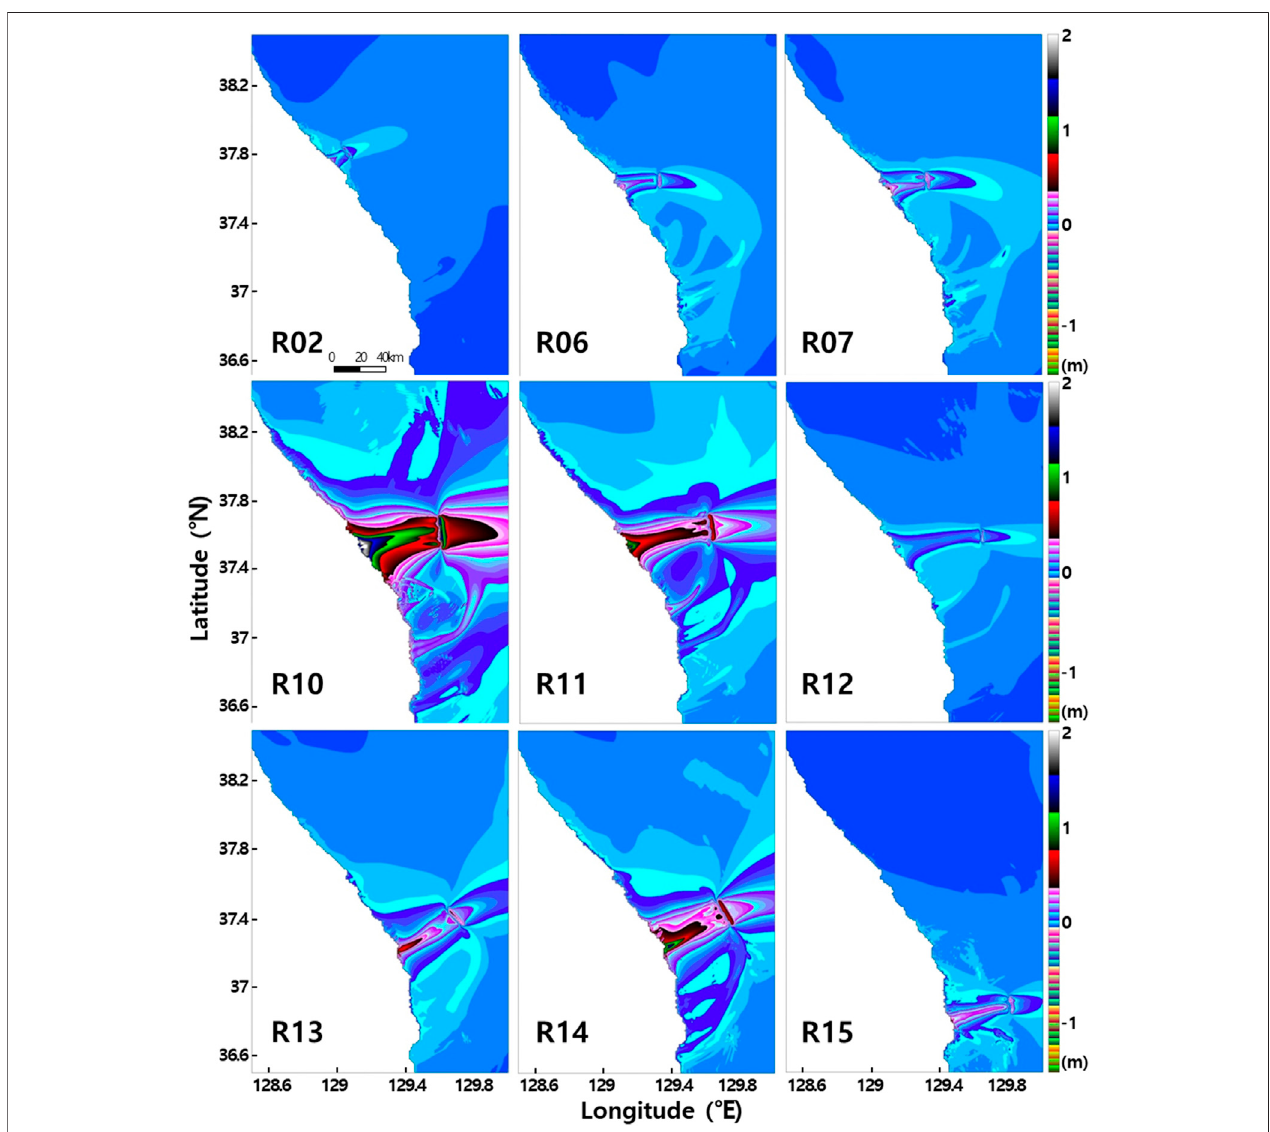
FIGURE 7 | Maximum wave height of tsunamis in the East Sea, estimated from numerical modeling for different scenarios (fault zones; Combination B).